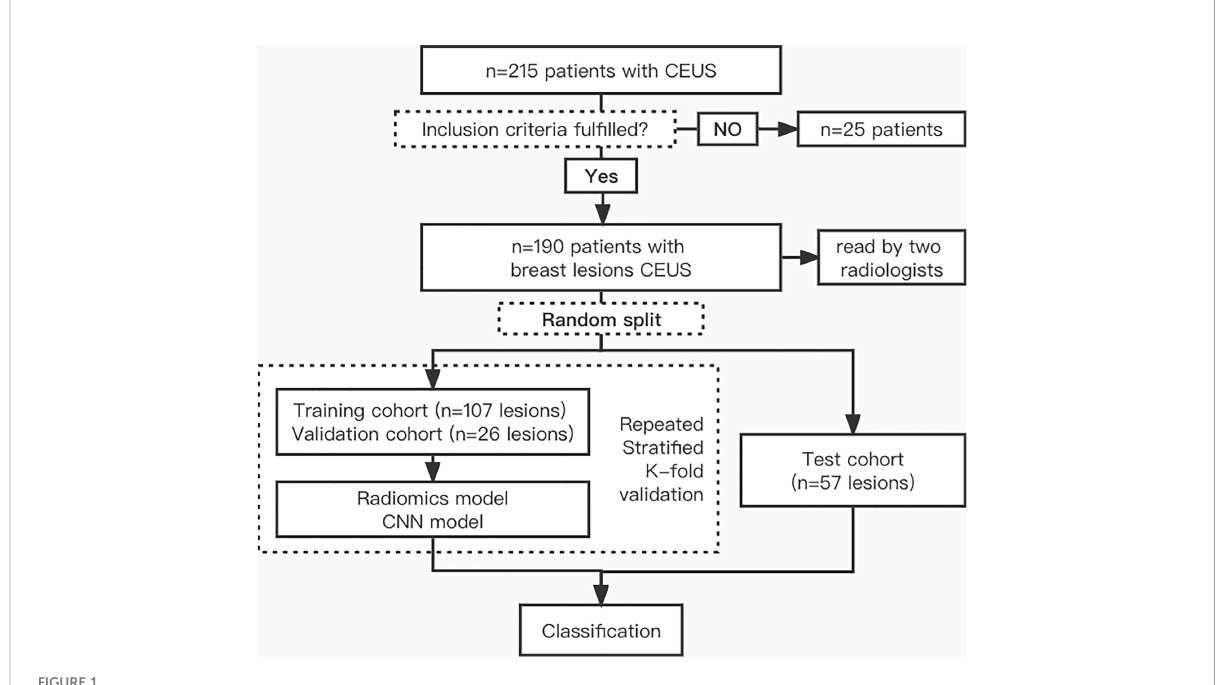
FIGURE 1 Flowchart of patient